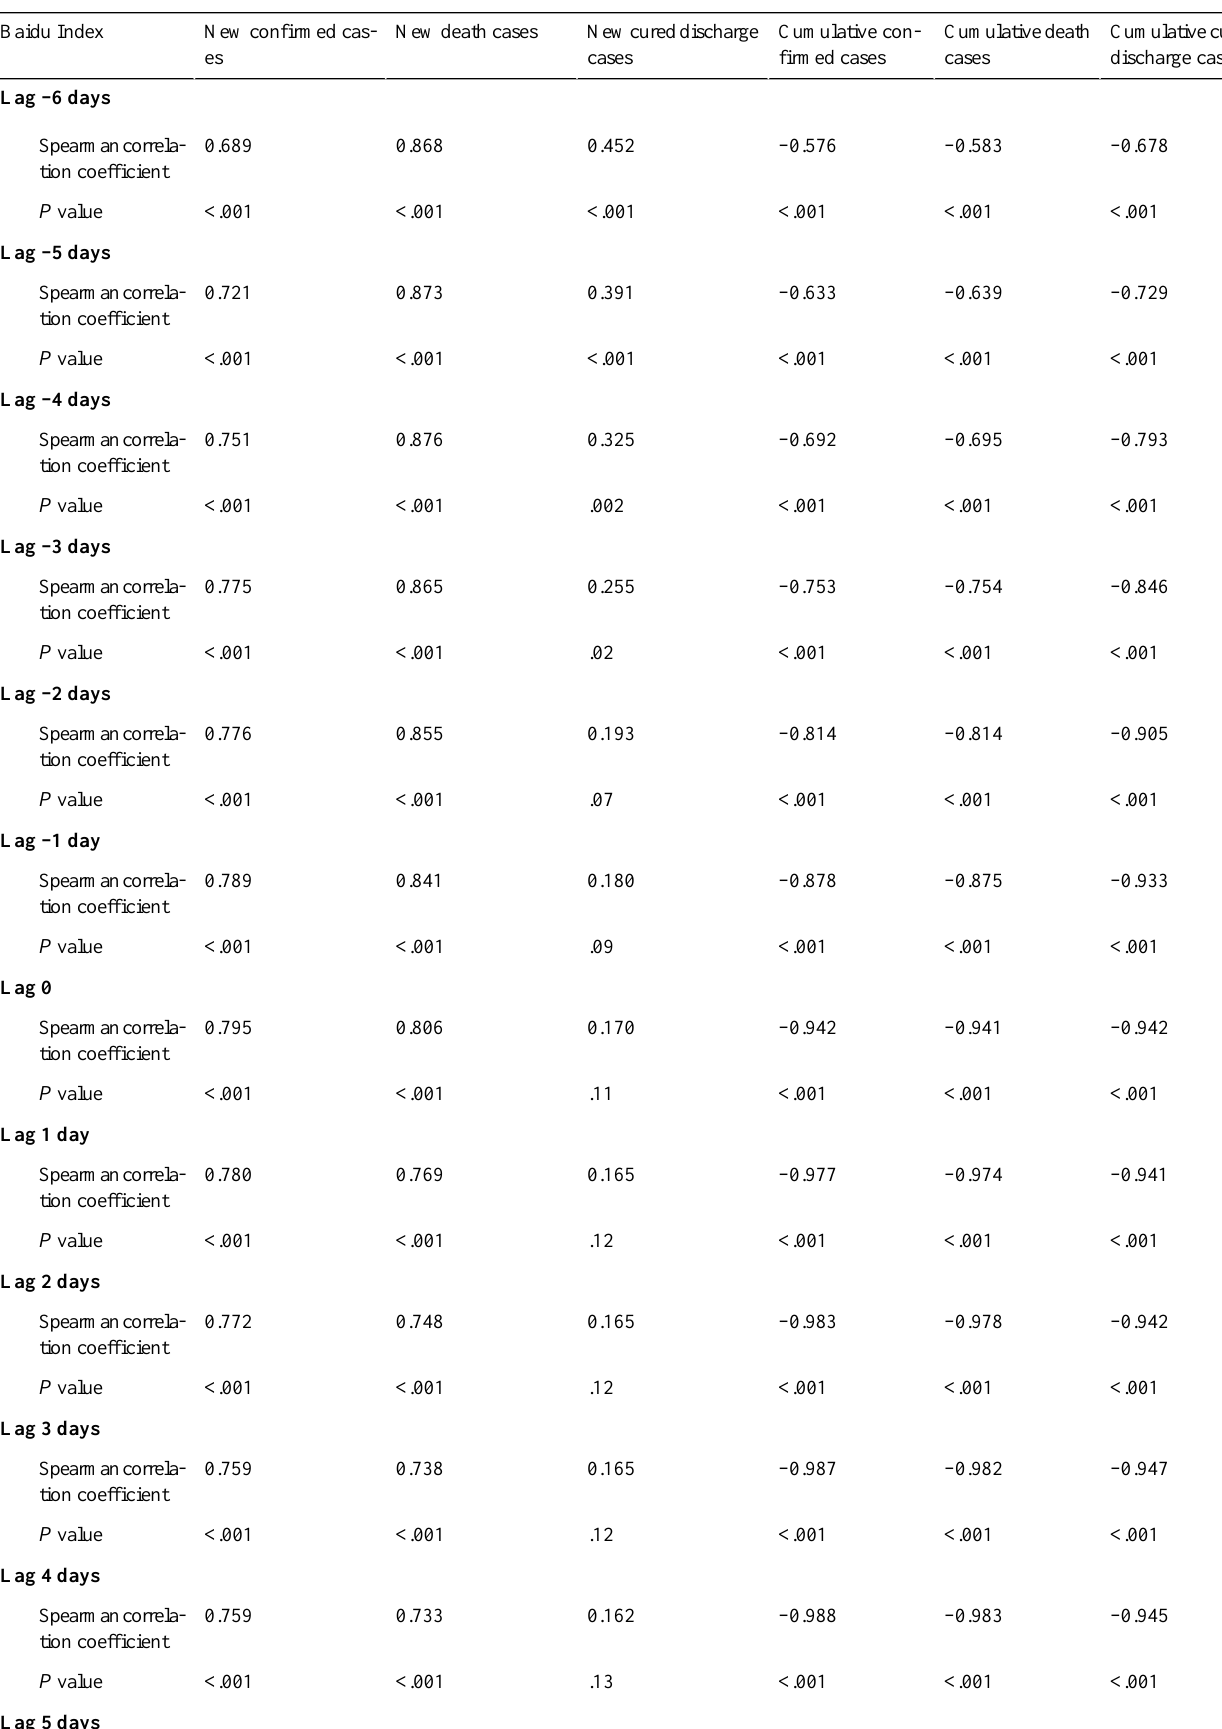
Table 2. The correlation between the national COVID-19 Baidu Index and real-world data from January 20 to April 20, 2020.